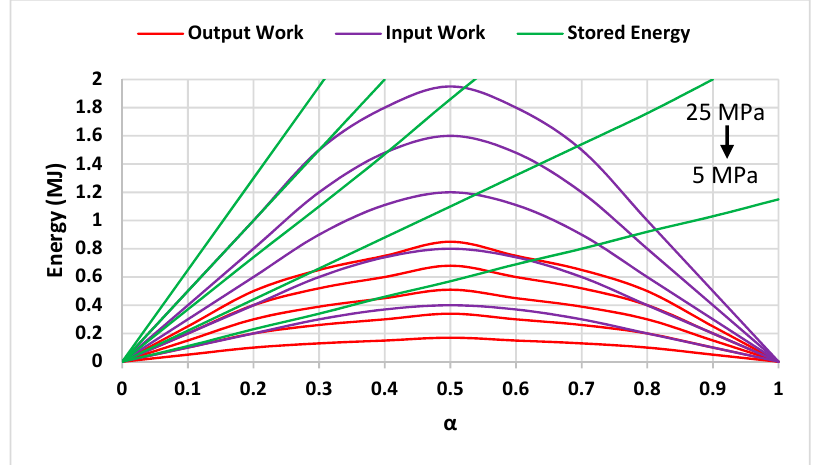
Figure 11. Changes in work input, output, and energy stored in the tank about α for different pres- sures and specific tank volume (1000 m 3 ).